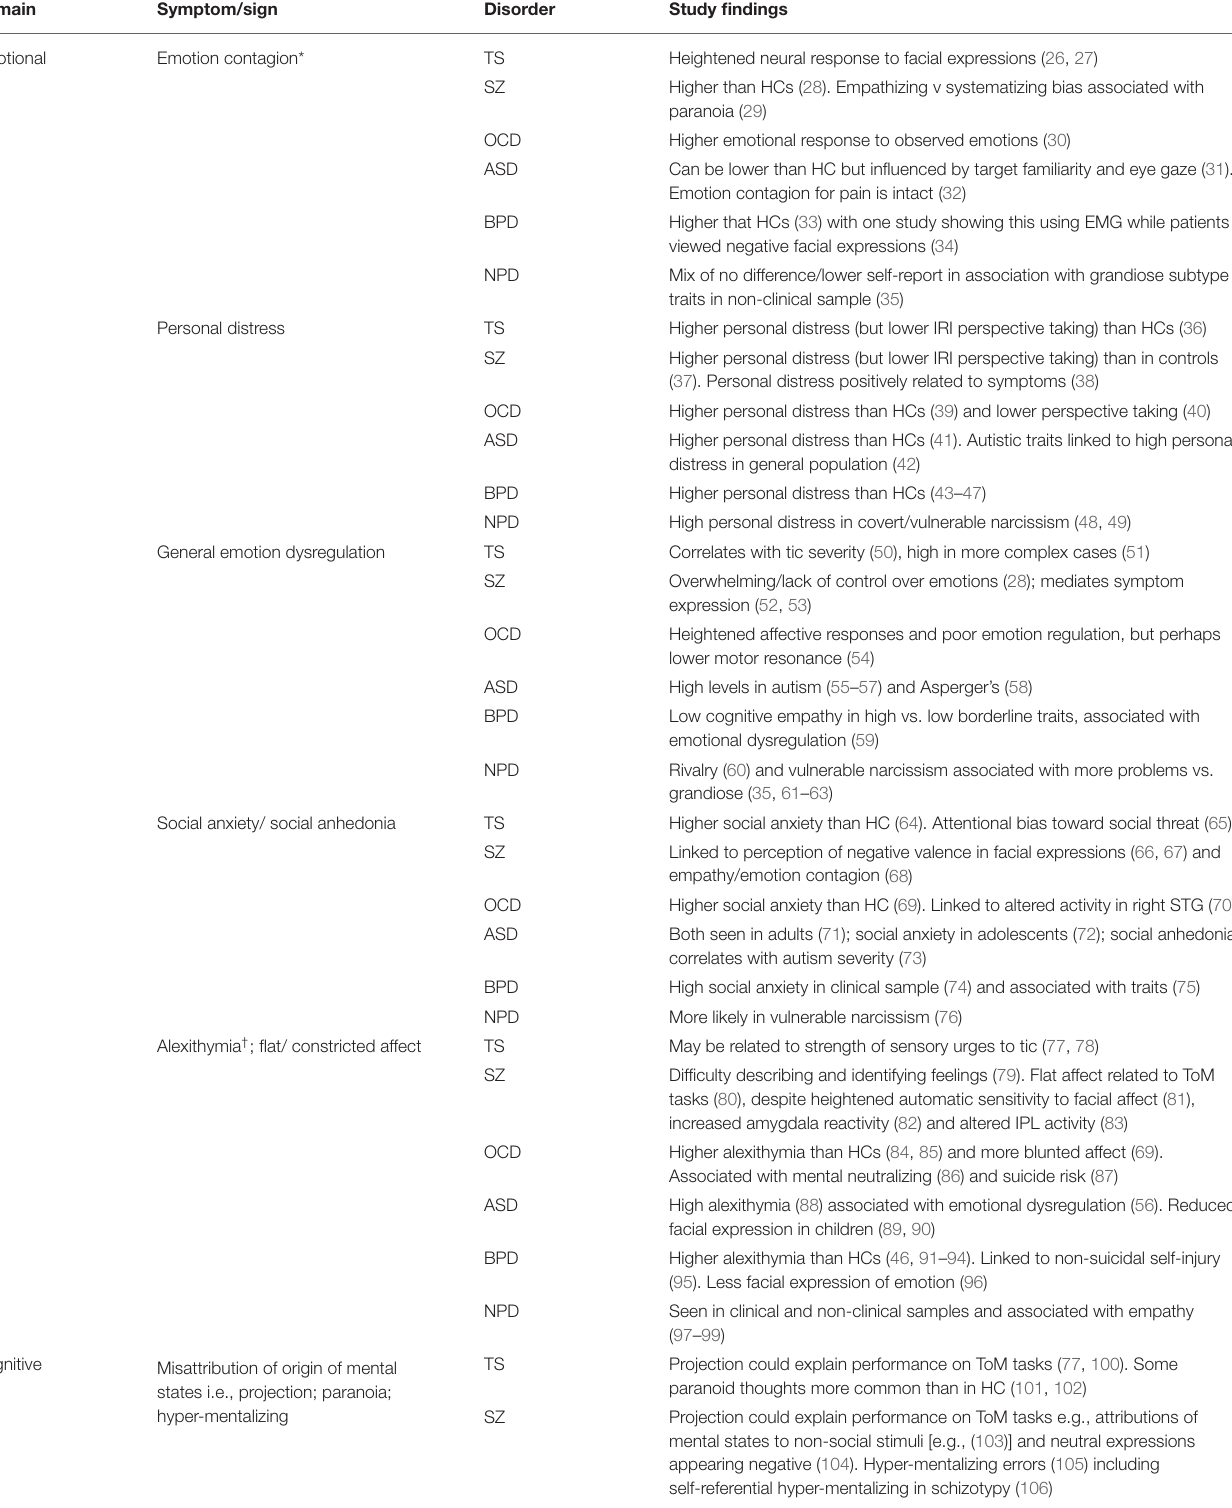
TABLE 2 | Evidence for problems with self-other distinction in psychiatric